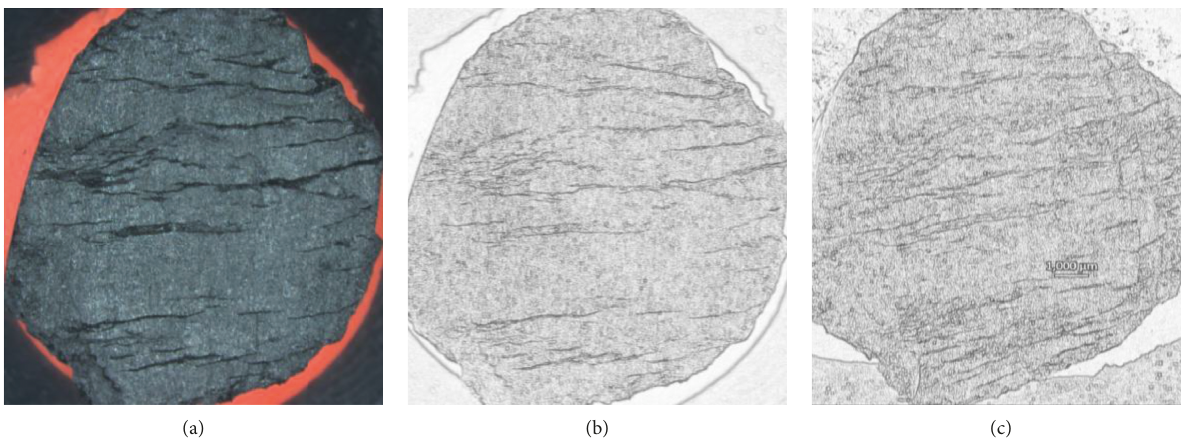
Figure 7: Sketch of the coal specimen in the natural state and water-saturated state. (a) Coal specimen D1-2. (b) Natural state. (c) Water- saturated